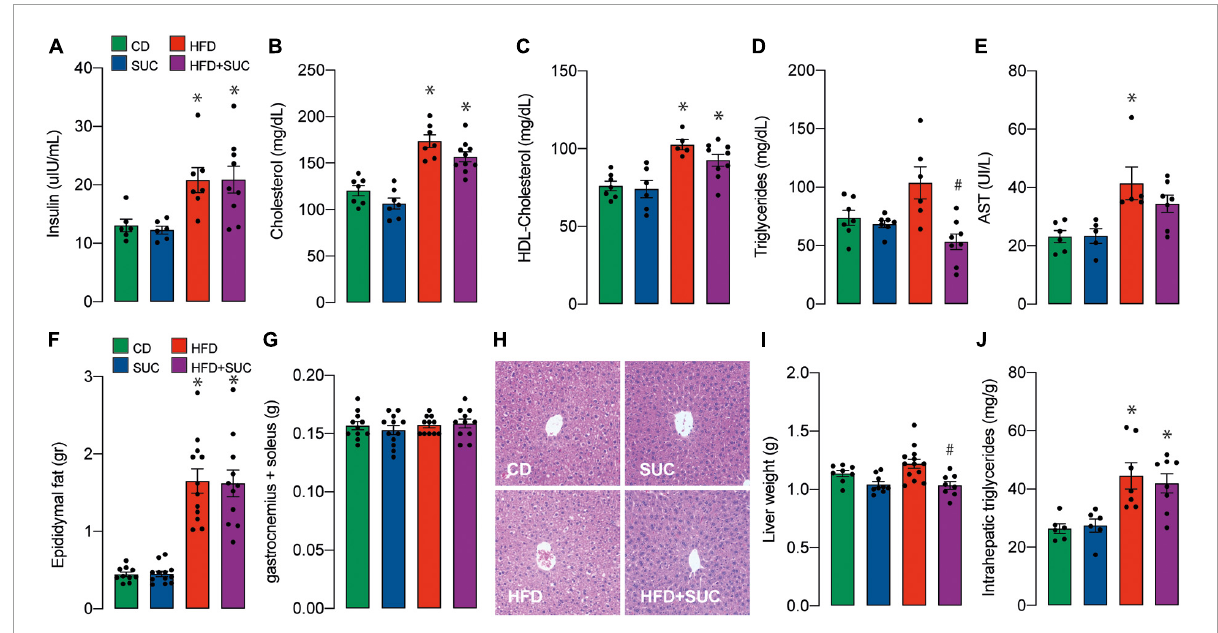
FIGURE3 Effect of sucralose on lipid profile, muscle, and adipose tissue. (A) Insulin. (B) Total cholesterol. (C) HDL-cholesterol. (D) Triglycerides. (E) AST. (F) Epididymal fat. (G) Gastrocnemius and soleus muscle. (H) Hematoxylin-eosin staining. (I) Liver weight. (J) Intrahepatic triglycerides. n = 6–8 mice per condition. Two-way analysis of variance (ANOVA) followed by Holm-Sidak’s post-hoc test. Values are expressed as mean ± SEM. * p < 0.05 vs. CD; # p < 0.05 vs.